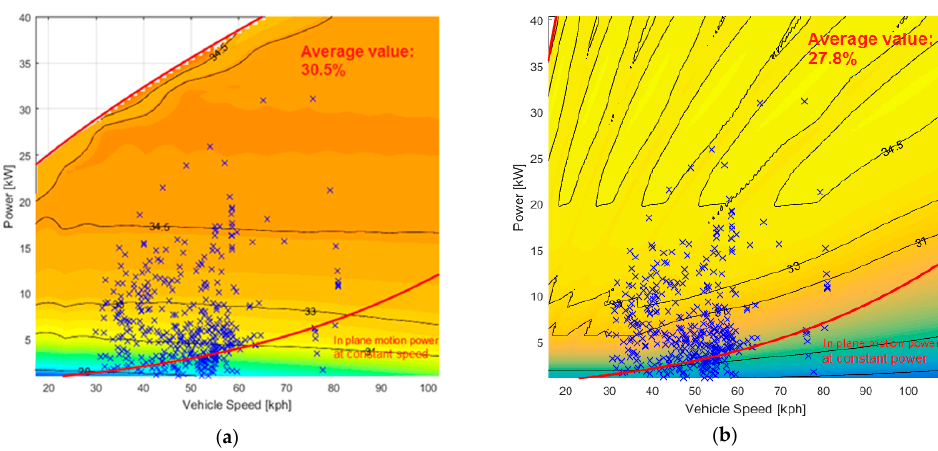
Figure 18. Extra-urban mission work points: ( a ) CVT ; and ( b ) DVT .